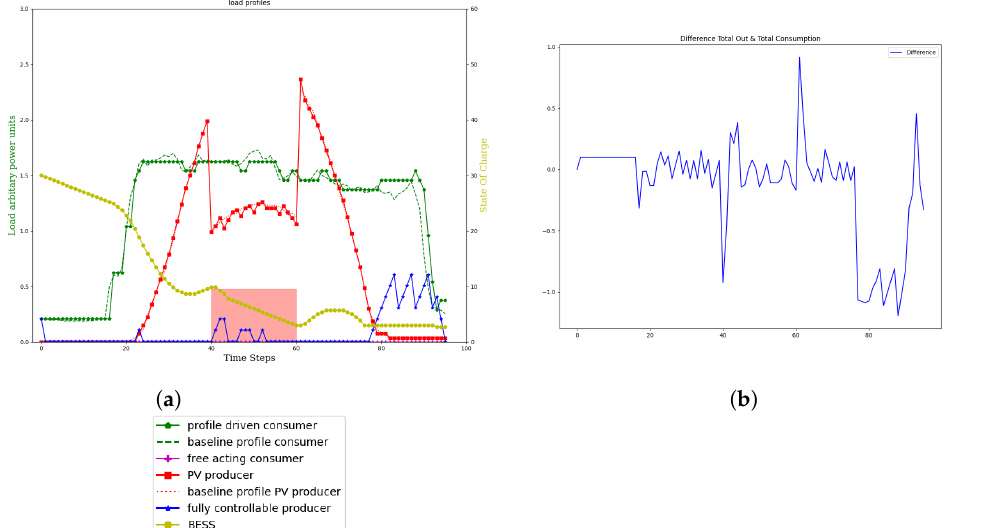
Figure 12. Evaluation with stressor on day 1, with PV agent stressed moderately. ( a ) Agent load curves and profiles. ( b ) Load balancing